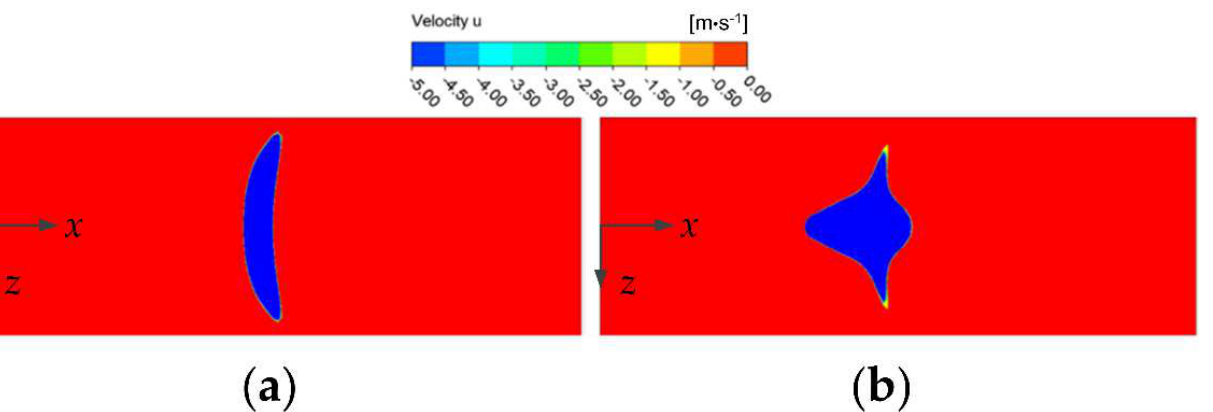
Figure 21. Numerical schlieren of two cross sections: ( a ) z = 0.025 m base flow field; ( b ) z = 0.025 m actuation flow field; ( c ) z = 0.054 m base flow field; ( d ) z = 0.054 m actuation field. Complementarily, the interaction region of the ISWBLI at the y = 0 cross section was also examined. Figure 22a,b shows the velocity contours at the ISWBLI zone with and without actuation. The images show that, after the array actuation was applied, the start of separation at the spanwise middle position moved forward, and the length of the separation zone was increased. At the same time, the length of the separation zone near the edge of the plate was reduced, and the spanwise, affected area of the separation zone was also diminished.